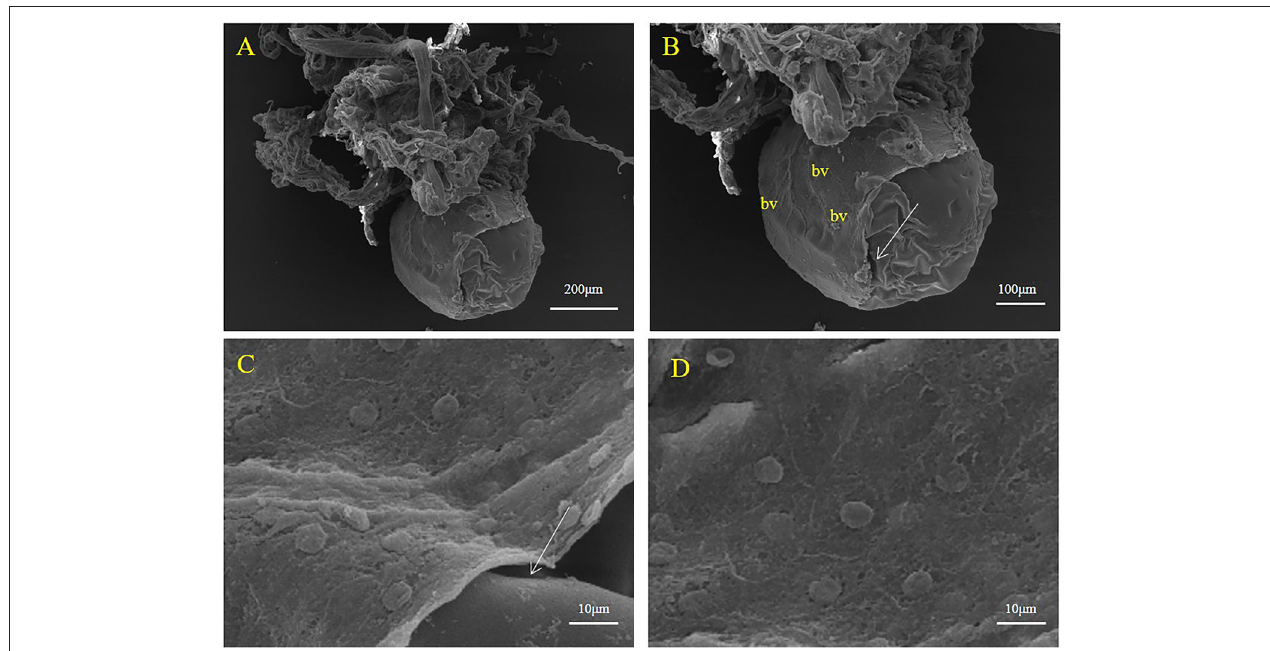
FIGURE 4 | Representative SEM images of the sac surface in S. schlegelii. (A) The embryo was suspended in branch structure. (B) Blood vessels (bv) and follicular epithelial cell layer. (C,D) Follicular epithelial cells. Gaps are marked with arrows. Scale bars, 200 µ m (A) ; 100 µ m (B) ; 10 µ m (C,D) .